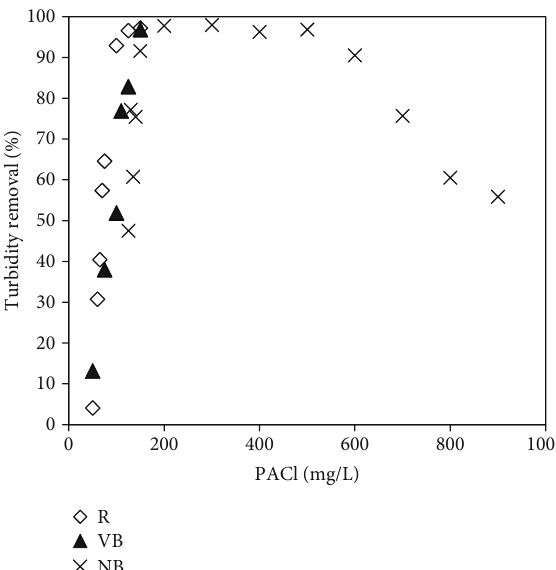
Figure 3: The e ff ect of PACl dosages on turbidity removal.